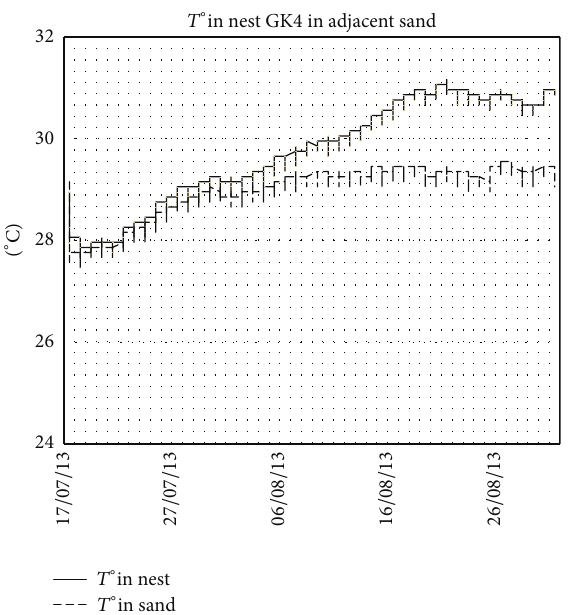
Figure 2: Temperatures in nest GK4 (normal nest) and in adjacent sand. Note the difference between inside and outside the nest due to metabolic heating.